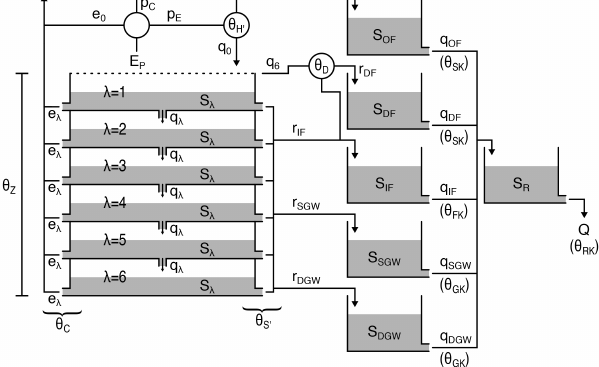
Figure 2. Conceptual representation of the SMART model struc- ture. P and E P , precipitation and potential evapotranspiration, re- spectively, are the model inputs; Q and E A , discharge and actual evapotranspiration, respectively, are the model outputs. For full de- scription of the parameters, states, and fluxes presented on the fig- ure, as well as the conceptual model equations, the reader is referred to the documentation provided in the